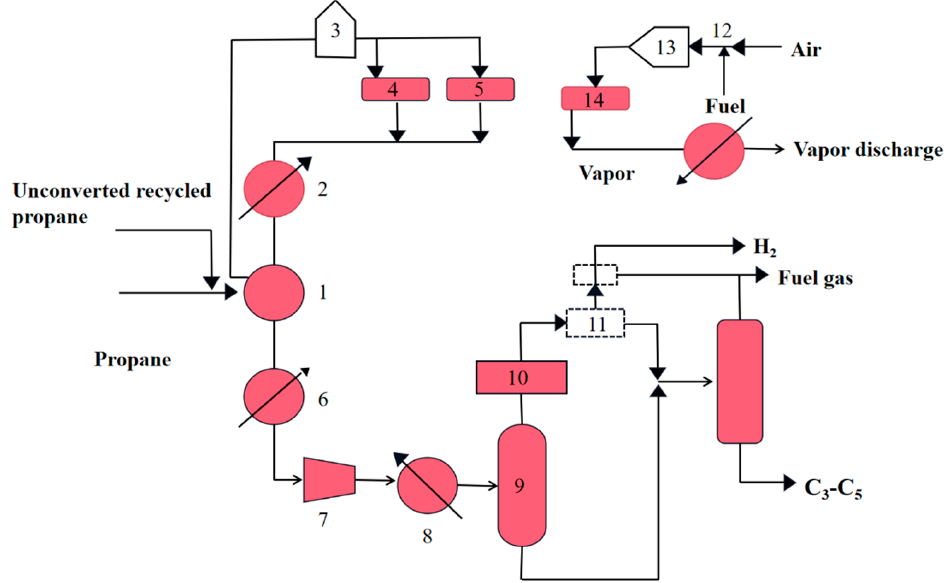
Figure 1. Process diagram of Catofin dehydrogenation unit. (1) Heat exchanger; (2) Steam generator; (3) Heating furnace; (4) Purge section reactor; (5) Process section reactor; (6) Cooler; (7) Compressor; (8) Air cooling; (9) Flash tank; (10) Dryer; (11) Cold box; (12) Gasifier; (13) Heater; (14)